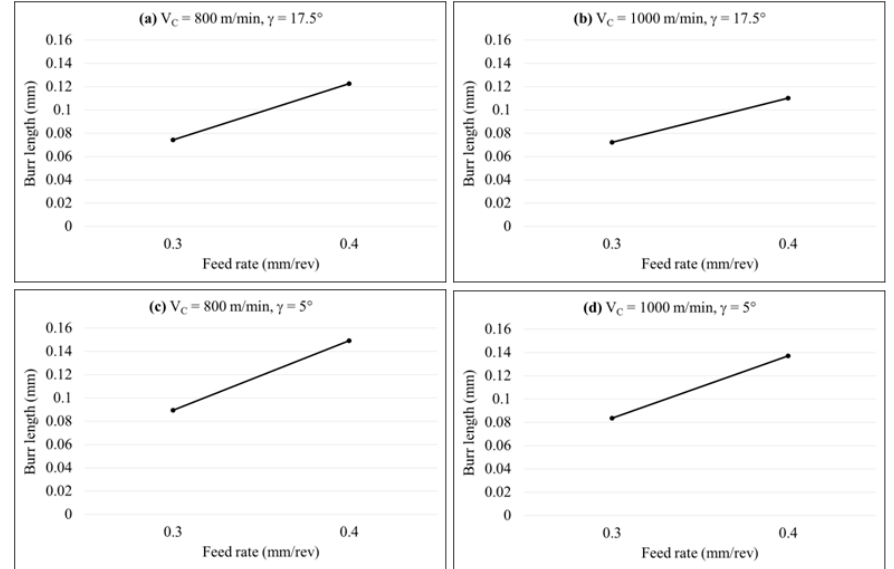
Figure 3. Effect of the cutting feed on end burr lengths measured along the x-axis at Z = 0 (middle section along depth of cut) ( a ) V C = 800 m/min, γ = 17.5° ( b ) V C = 1000 m/min, γ = 17.5° ( c ) V C = 800